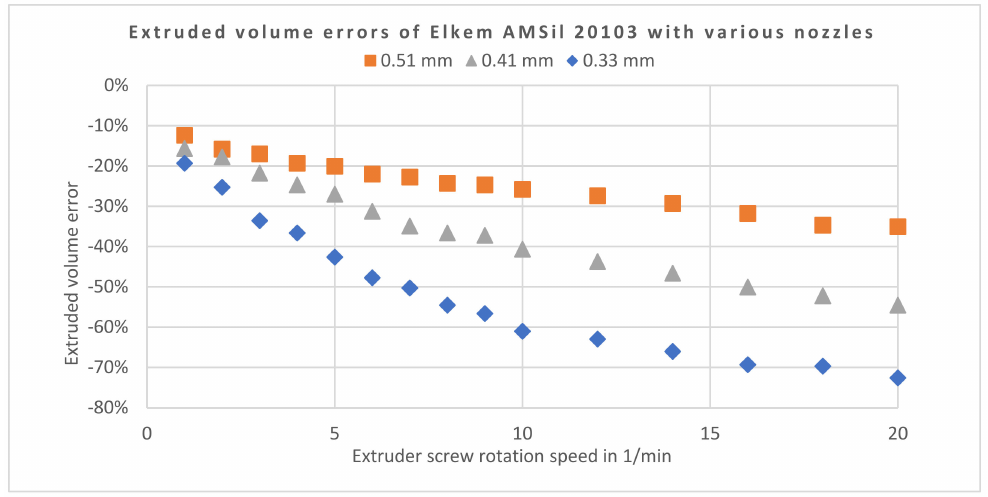
Figure 5. Extruded volume errors against extrusion speed with three different nozzle diameters using the 20103 silicone. The other two silicones showed similar behavior.